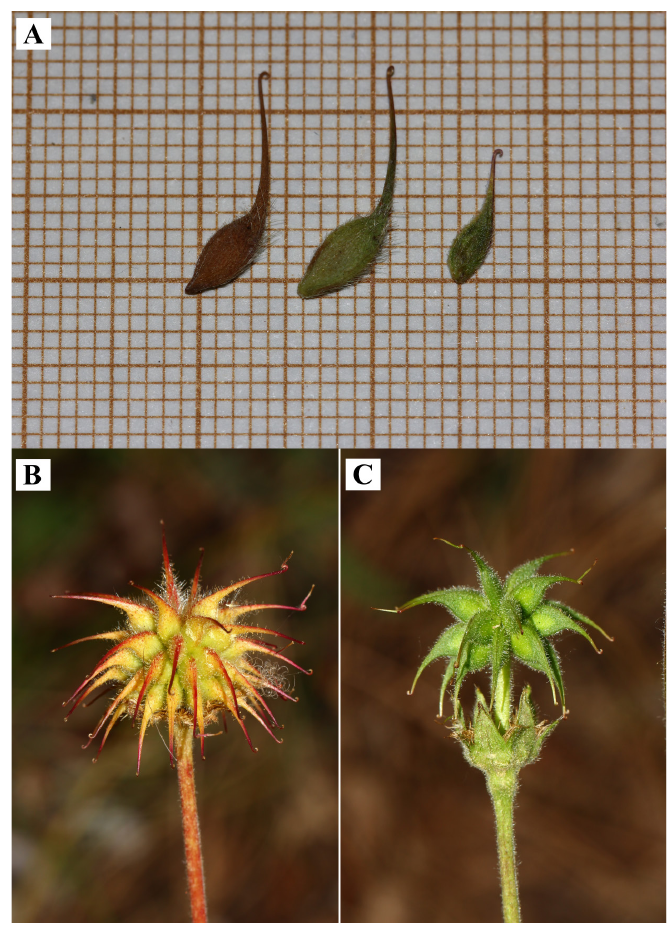
Figure 2. Main differences between Geum atlanticum and G. sylvaticum . A, Achenia. Left and central achenia belong to Geum atlanticum . Right achenium belongs to G. sylvaticum ; B,